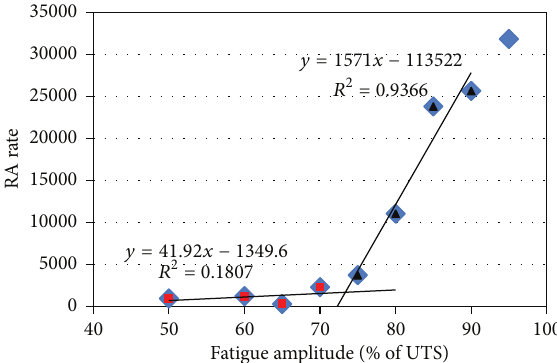
Figure 15: RA increasing rate for different fatigue loading ampli-